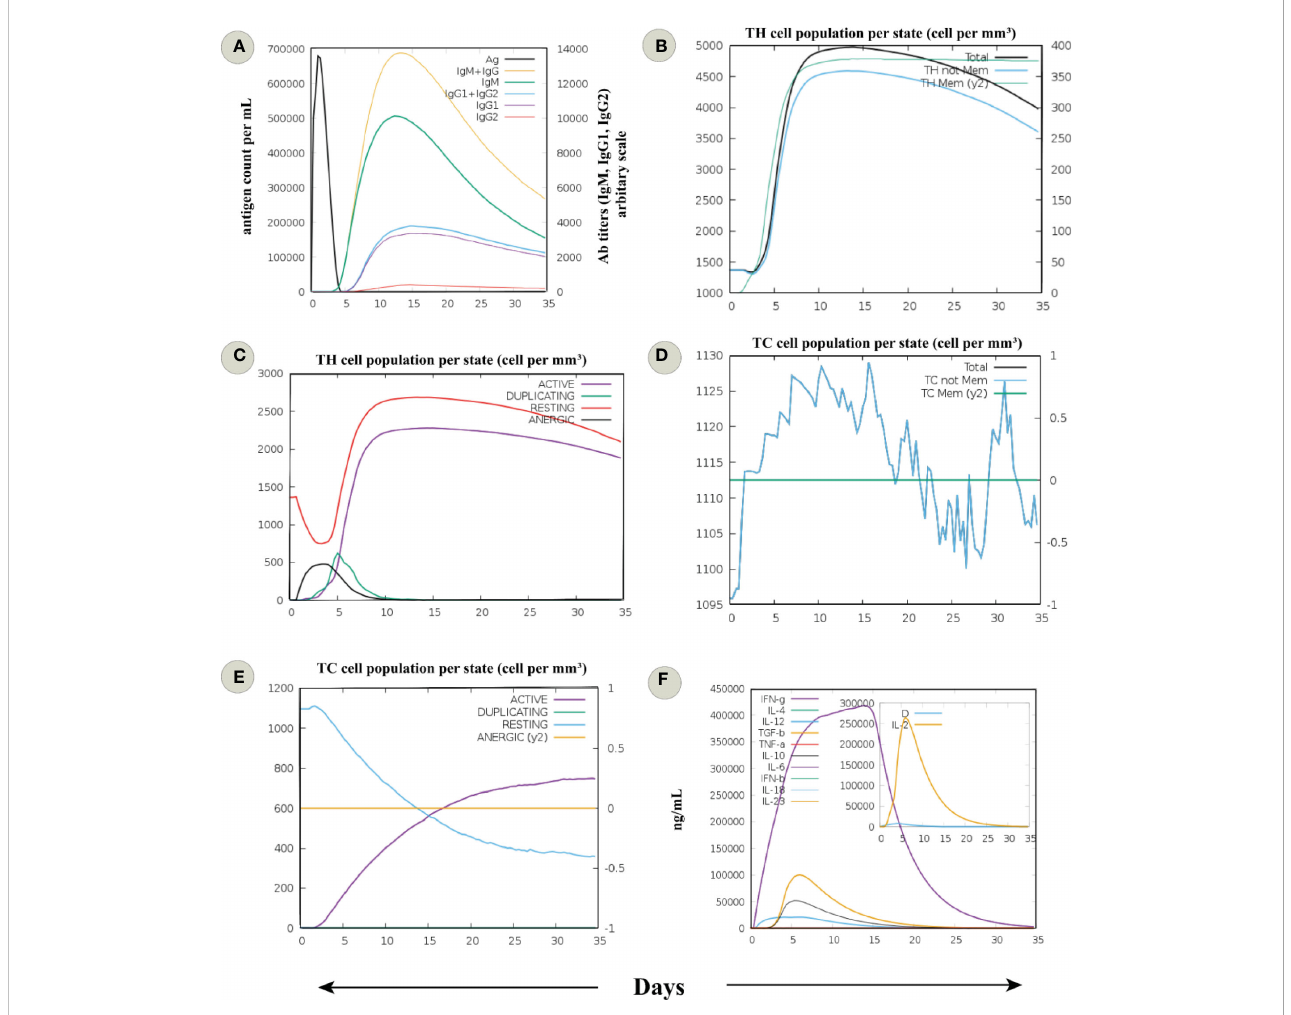
FIGURE 4 In silico immune simulation of an infection challenge, comprised of a virus responding to the sequence of MPXV proteins covered by the designed putative vaccine, was simulated for 35 days. (A) Immunoglobulin response against the antigen or vaccine. The development of immunoglobulin and immunocomplexes after the immunization signi fi es the induction of the humoral immune response with a change towards the diverse subtypes of immunoglobulins (immunoglobulin G (IgG), being more predominant). (B) The cell count of total and memory CD4+ T-helper (TH) lymphocytes. (C) The cell count of TH lymphocytes is shown in various forms, i.e., active, duplicating (in the mitotic cycle), resting (not active), and anergic. (D) The cell count of total and memory CD8+ T-cytotoxic (TC) lymphocytes. (E) The cell count of TC lymphocytes in various forms, i.e., active, duplicating (in the mitotic cycle), resting (not active), and anergic . (F) Levels of cytokines and interleukins. D in the inset plot is a danger signal and leukocyte growth factor